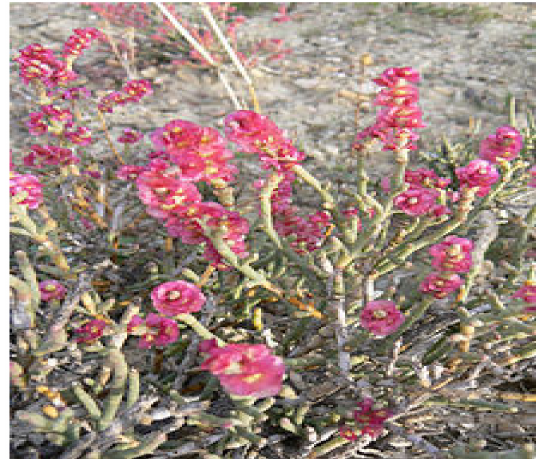
Figure 1. The A. articulata